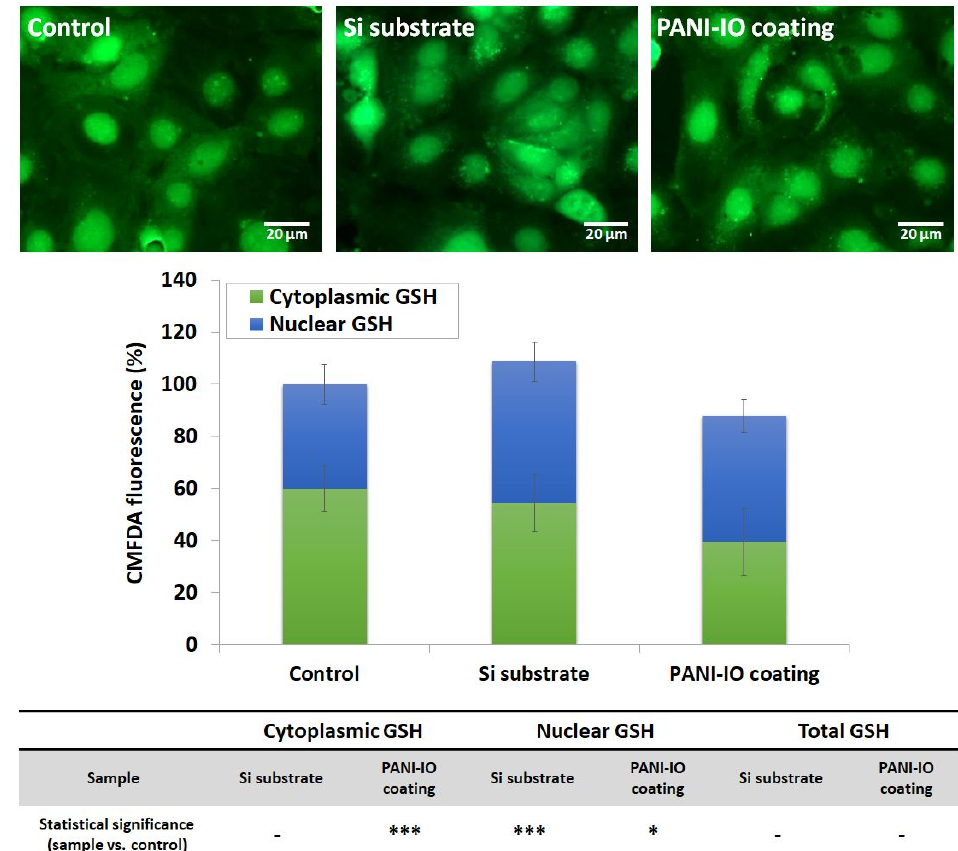
Figure 10. CMFDA relative fluorescence in cytoplasm and nucleus of Caco-2 cells cultured on Si substrate and PANI-IO coating for 24 h. Green fluorescence indicates GSH staining by CMFDA fluorescent dye. Control represents cells cultured in the absence of substrates. The graph is the corresponding fluorescence quantification of microscopy images presented above. The results were calculated as a percentage of the total GSH of each sample, normalized to control, and expressed as a percentage of nuclear and cytoplasmic GSH content. Magnification: 10×. Scale bar: 20 µm. Statistical significance was calculated, related to control, for each experimental condition (* p < 0.05 and *** p < 0.001 vs. control).